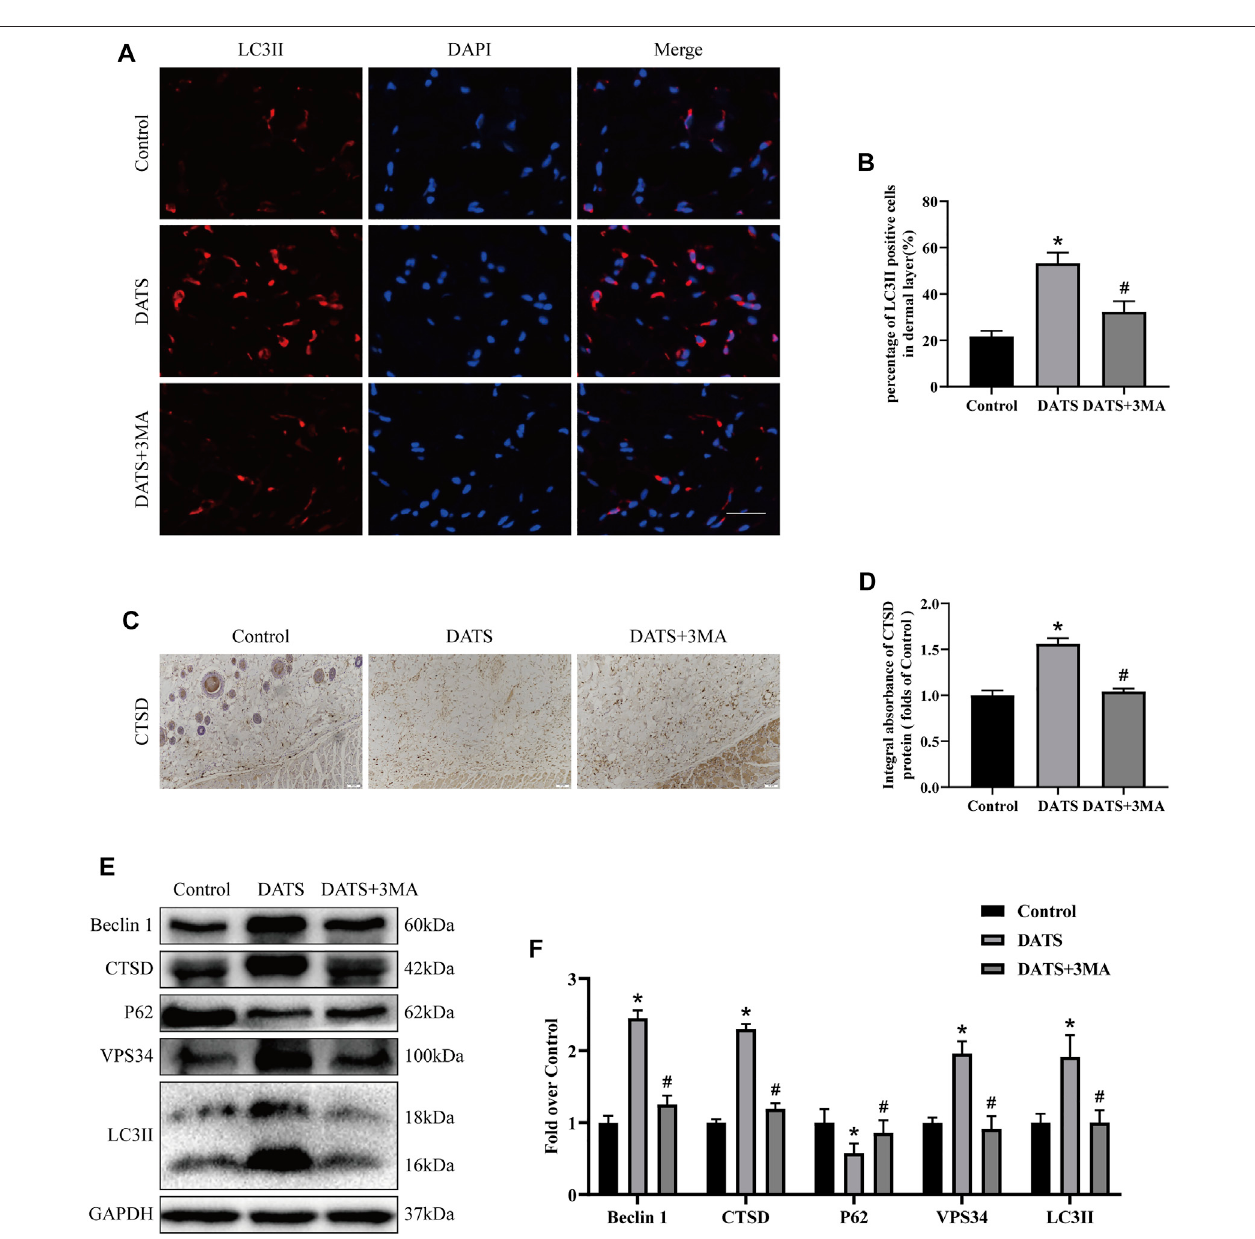
FIGURE3| DATSinducesautophagyinthemultiterritory perforator fl ap. (A) Autophagosomes(LCII,red)andnuclei(DAPI, blue)incellsinthechokeIIzoneof fl aps in the control, DATS, and DATS+3MA groups (scale bar: 50 µm). (B) Statistical chart of the percentage of the LC3-positive cells. (C) IHC for CTSD in the multiterritory perforator fl ap in each group (original magni fi cation ×200; scale bar, 50 µm). (D) Statistical chart of the CTSD expression level estimated by IHC. (E) Western blotting of autophagymarkers,Beclin1,CTSD,LC3II,VPS34,andp62inthecontrol,DATS,andDATS+3MAgroups.Allthegelelectrophoresisexperimentswerecarriedout underthesameexperimentalconditions. (F) Statisticalchartofthequanti fi cationofBeclin1, CTSD,LC3II,VPS34, andp62expressionsintheperforator fl aps.* p < 0.05, vs. controlgroup; # p < 0.05,vs.DATSgroup.Theobtaineddatawereexpressedasmeans±SEM, n =6foreverygroup.DATS,diallyltrisul fi de;3MA,3-methyladenine; IHC,